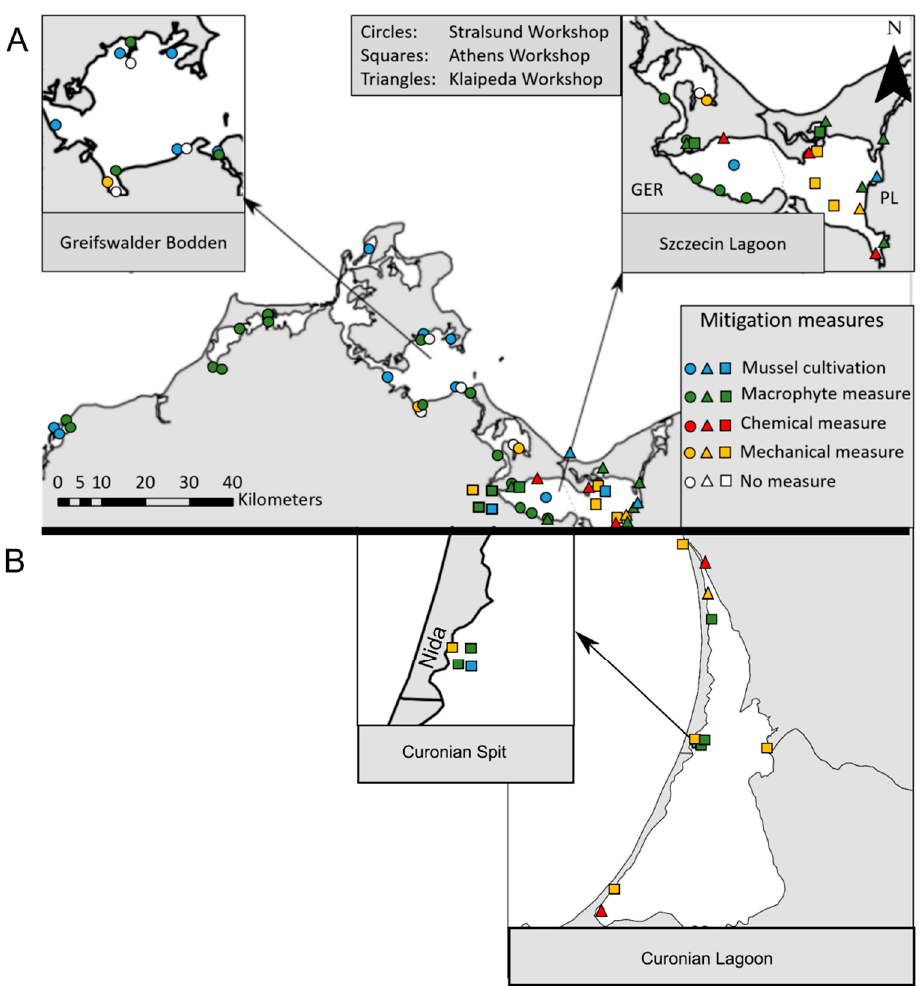
Figure 4. Locations of the flags for potential installation sites of sea-based measures for nutrient removal which the participants pinned during the workshops in Stralsund, Germany (23 January 2018; symbol: circle), in Athens, Greece (22 March 2018; symbol: square), and in Klaipeda, Lithuania (24 May 2018; symbol: triangles). ( A ) German and Polish coastal waters, with focus on the Greifswalder Bodden and the Szczecin Lagoon. ( B ) Lithuanian coastal waters, with focus on the Curonian Spit. Table 4. Amount of flags pinned for potential installation sites for different internal nutrient removal measures. The round brackets show the percentages per workshop, the square brackets show the percentage distribution across all workshops, and the curved brackets the total share of all measures pinned.